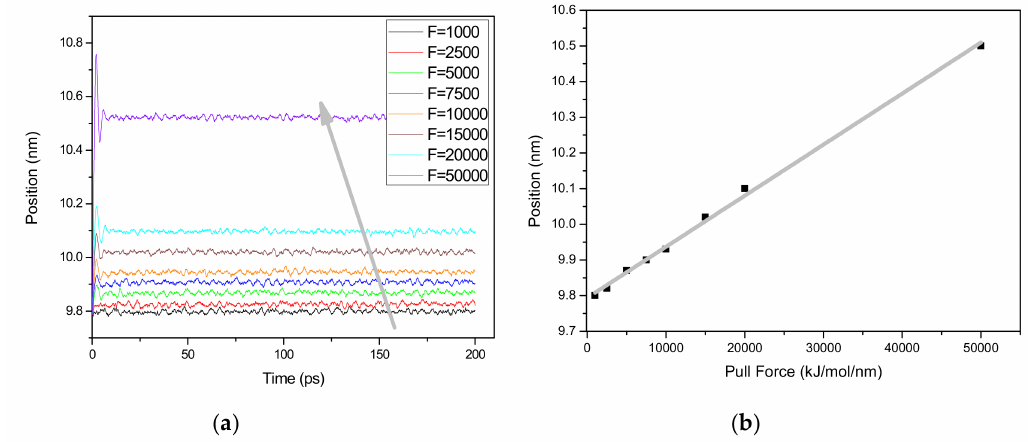
Figure 5. Strain response over simulation time: ( a ) With time and ( b ) with pulling